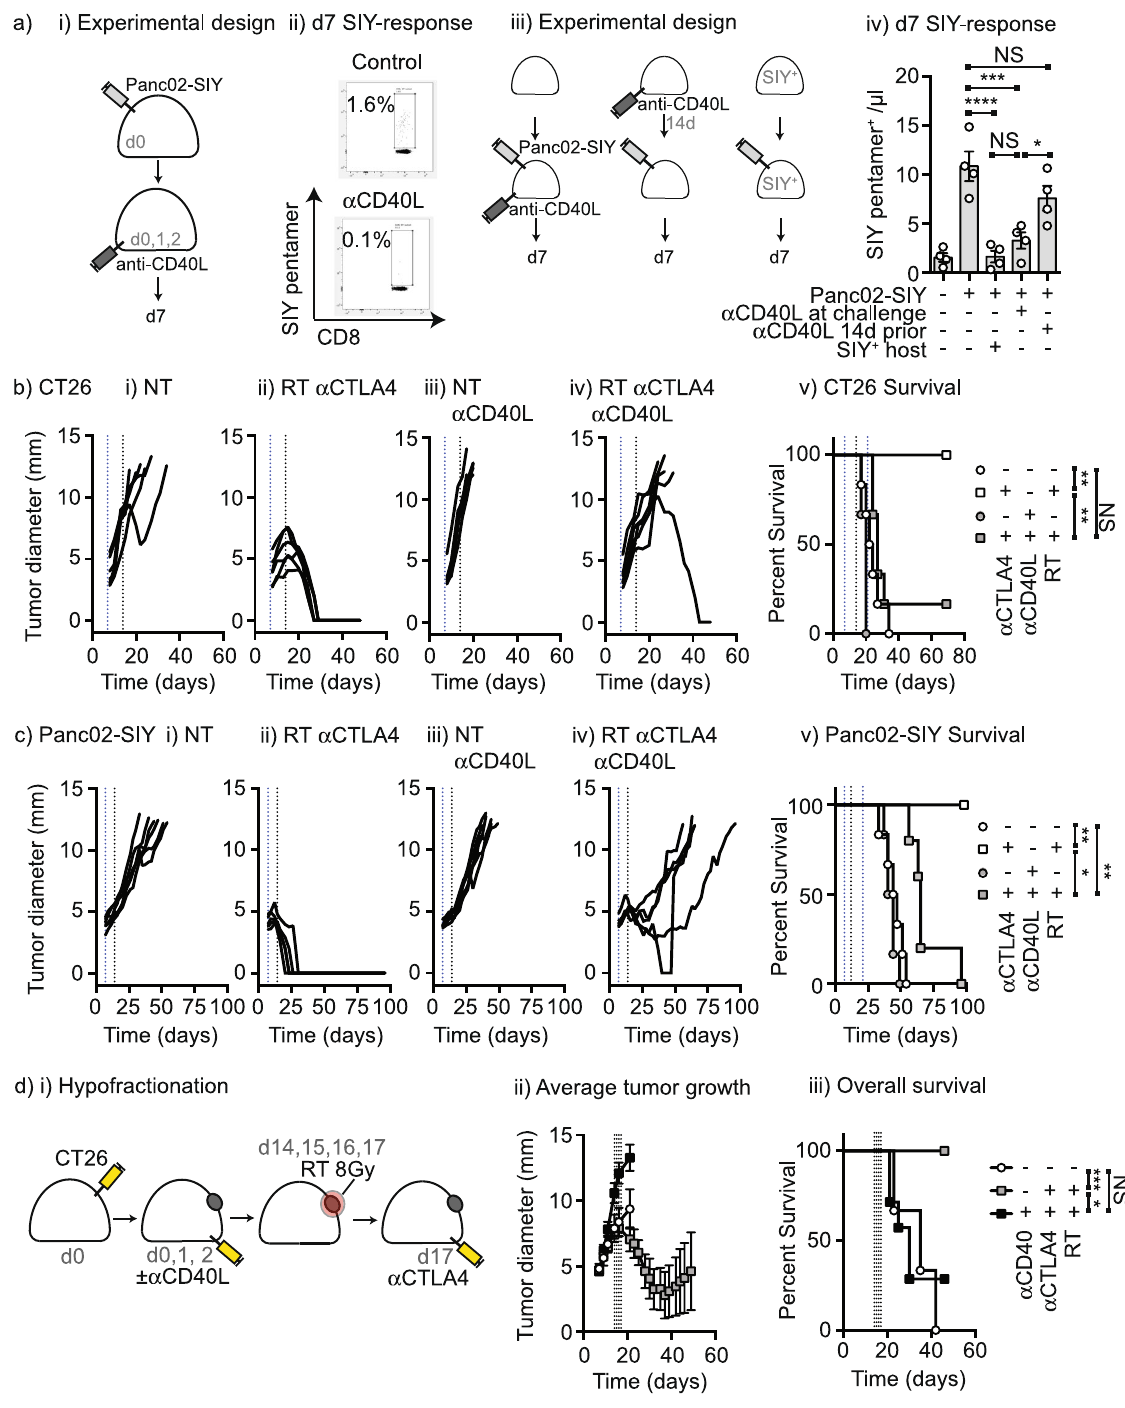
Figure 3. Anti-CD40L at tumor implantation eliminates tumor control by subsequent radiation therapy and checkpoint inhibition. ( a ) (i) Mice were implanted with Panc02-SIY tumors on d0 and left untreated or treated with 100 µ g anti-CD40L on d0, d1 and d2. ii) SIY-specific pentamer binding cells in the peripheral blood 7d following tumor implantation in control and anti-CD40L-treated mice. iii) Panc02-SIY were implanted into wild-type mice on d0 and mice were left untreated or treated with 100 µ g anti-CD40L on d0, 1, and 2 or two weeks previously (on d-14, -13, -12). Control mice received no tumor implantation, or Panc02-SIY implantation into SIY + mice that were tolerant to SIY. iv) SIY-specific pentamer binding cells in the peripheral blood 7d following tumor implantation. ( b ) Mice were implanted with CT26 and i) left untreated; ii) treated with anti- CTLA4 on d7 and radiation on day 14; iii) treated with 100 µ g anti-CD40L on d0, 1, and 2 iv) treated with 100 µ g anti-CD40L on d0, 1, and 2 then treated with anti-CTLA4 on d7 and radiation on day 14; v) Overall survival of treatment groups. ( c ) Mice were implanted with Panc02-SIY and i) left untreated; ii) treated with anti-CTLA4 on d7 and radiation on day 14; iii) treated with 100 µ g anti-CD40L on d0, 1, and 2 iv) treated with 100 µ g